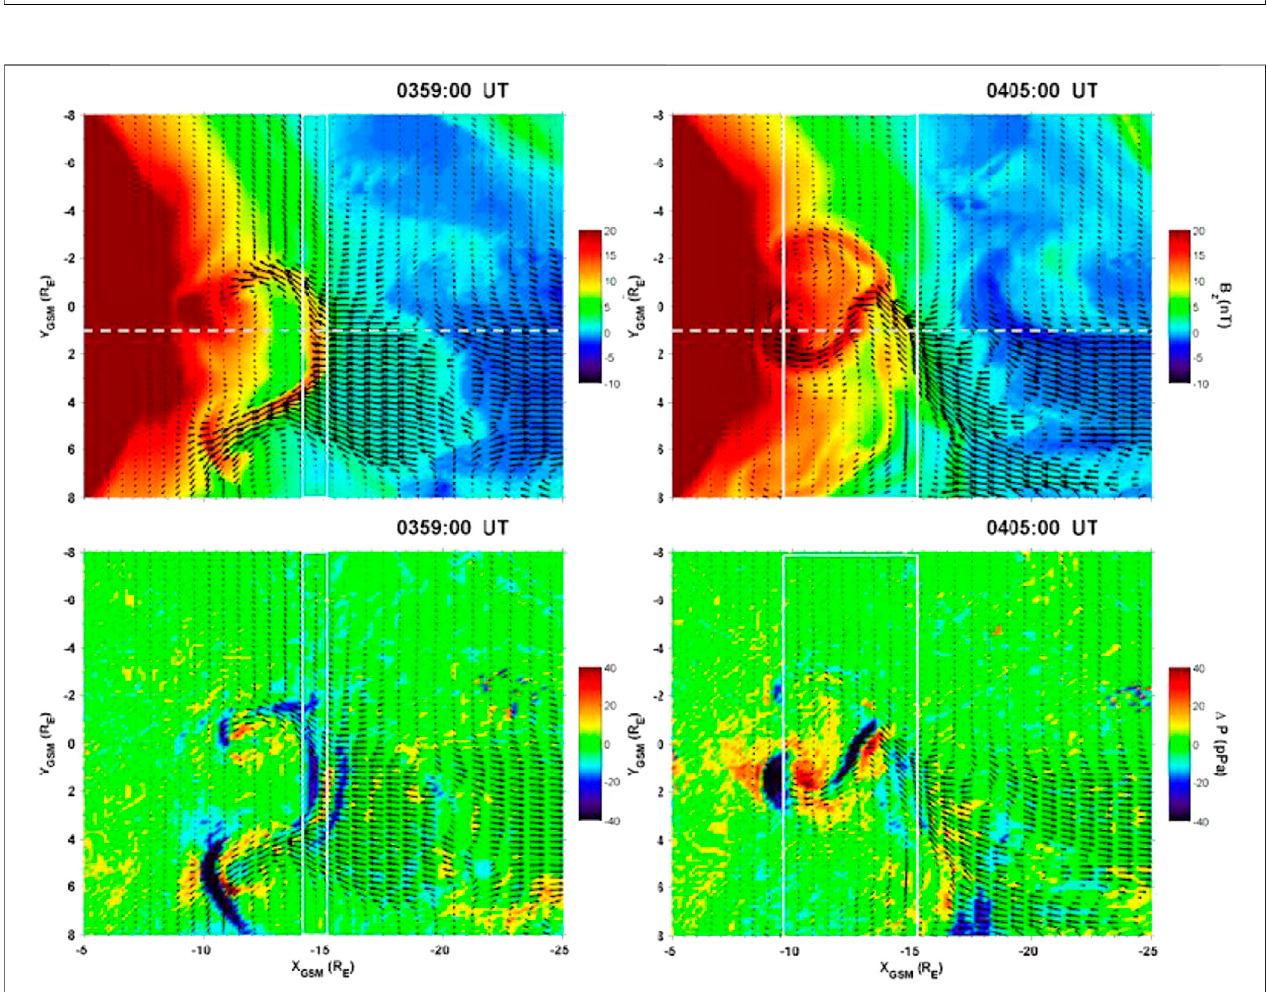
FIGURE7| MHDresultsonthemaximumpressuresurfaceattwotimes(GSMcoordinates).Inthetoppanel,colorcontoursshow Bz andtheblackarrowsgivethe fl ow velocity. Dipolarization fronts are located between the vertical white lines. Dipolarization fronts are clearly visible as areas of high magnetic fi elds which are moving earthward. The bottom panels show the change in thermal pressure from a baseline 10 s before. (After El-Alaoui et al., (2013)).